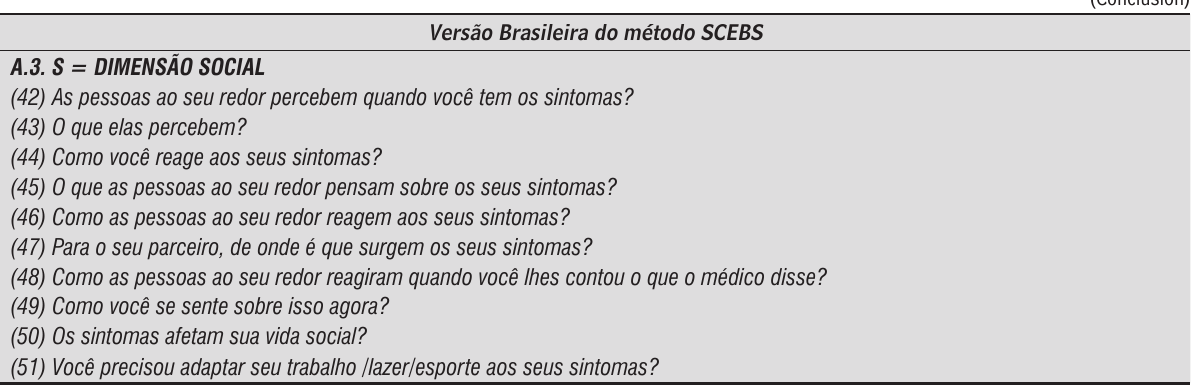
Figure 1 - Portuguese version of the SCEBS